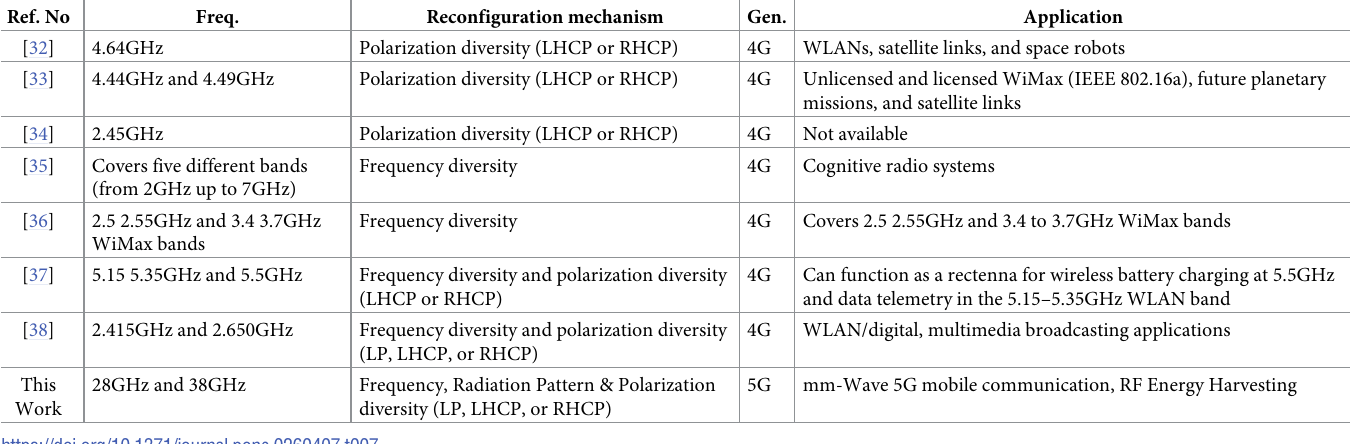
Table 7. Comparison table of published literature. Ref. No